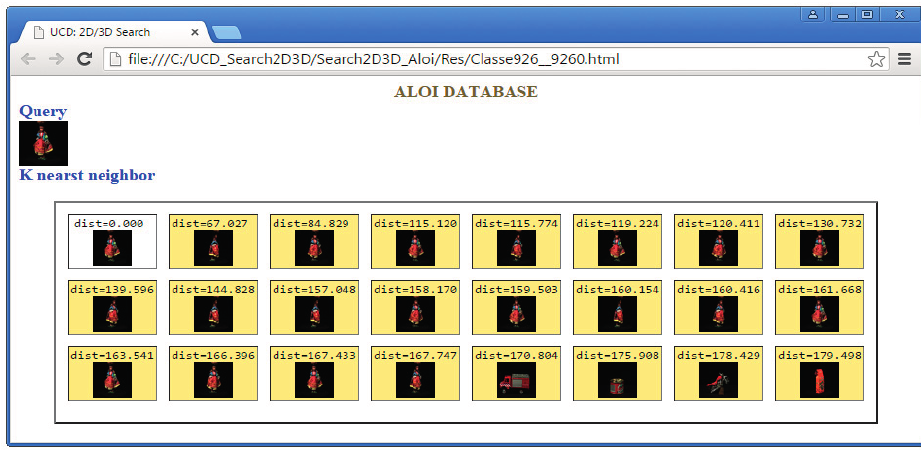
Figure 10. Example of a query and its 25 similar views obtained by using the k -nearest neighbor